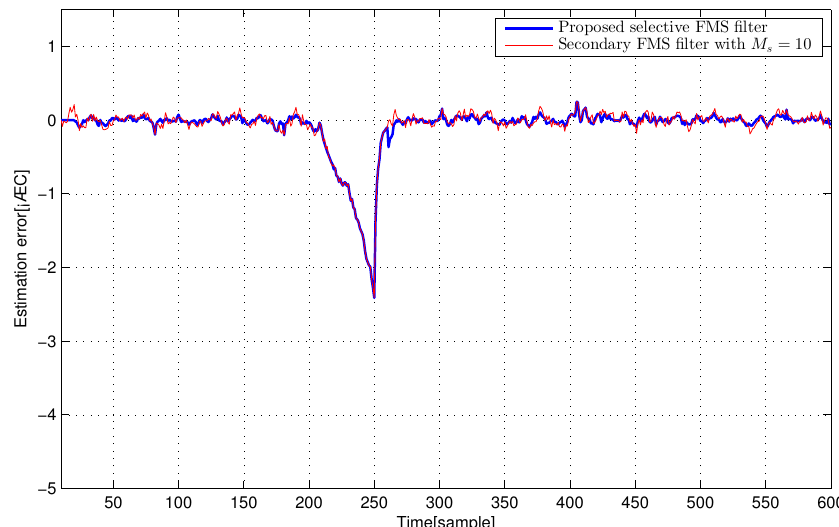
Figure 7. Estimation errors of the proposed selective FMS and secondary FMS filters for the F404 gas turbine aircraft engine system.